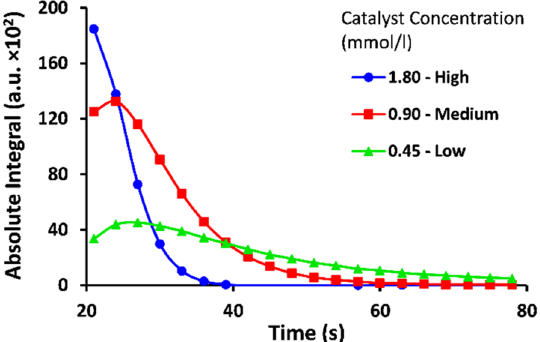
Figure 4. Signal intensities of the hyperpolarized protons during the reaction of 1 mM of the peptide F1PrgAc ( 2-A1 ) with parahydrogen at different catalyst concentrations. The reaction was started by bubbling parahydrogen for 15 s and then followed by a series of short acquisition pulses with 5° flip angles. At a low concentration of catalyst, the initial reaction rate is slow and the maximum in signal intensity is low but the polarization is maintained over a longer period of time. At a high catalyst concentration, the initial reaction rate and the maximum intensity are much higher and the maximum in signal intensity is reached immediately after